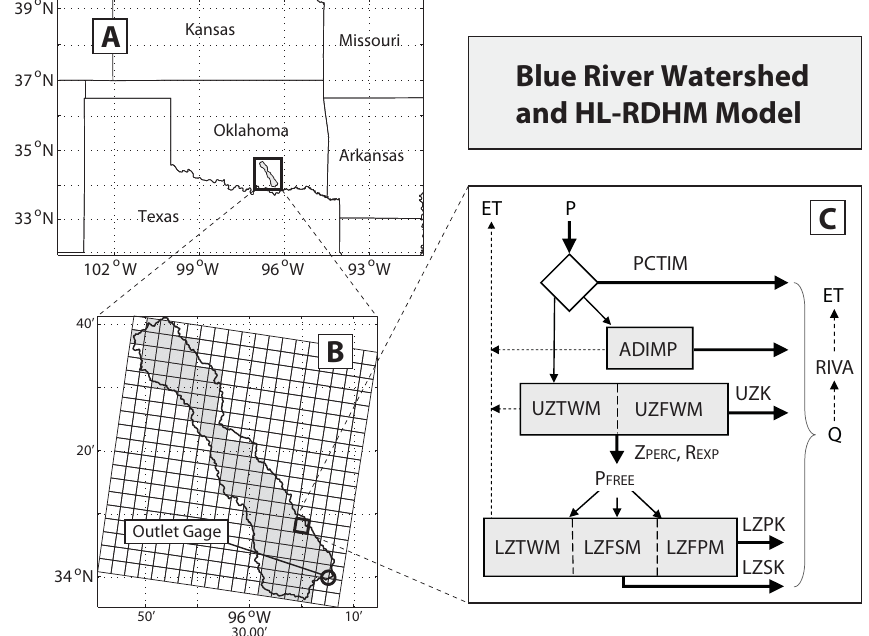
Fig. 1. (A) Location of the Blue River basin in southern Oklahoma, USA. (B) The 78 HRAP grid cells of the Blue River basin (shaded). (C) The Sacramento Soil Moisture Accounting (SAC-SMA) model, which simulates the water balance in each grid cell.